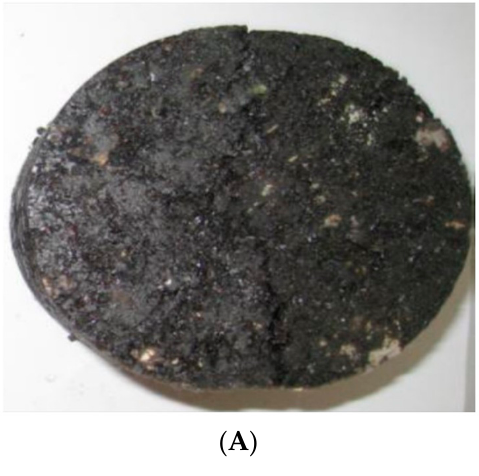
Figure 14. Cold recycling asphalt mixture ( A ) Emulsified asphalt cold recycling, ( B ) Foam cold re- cycling.